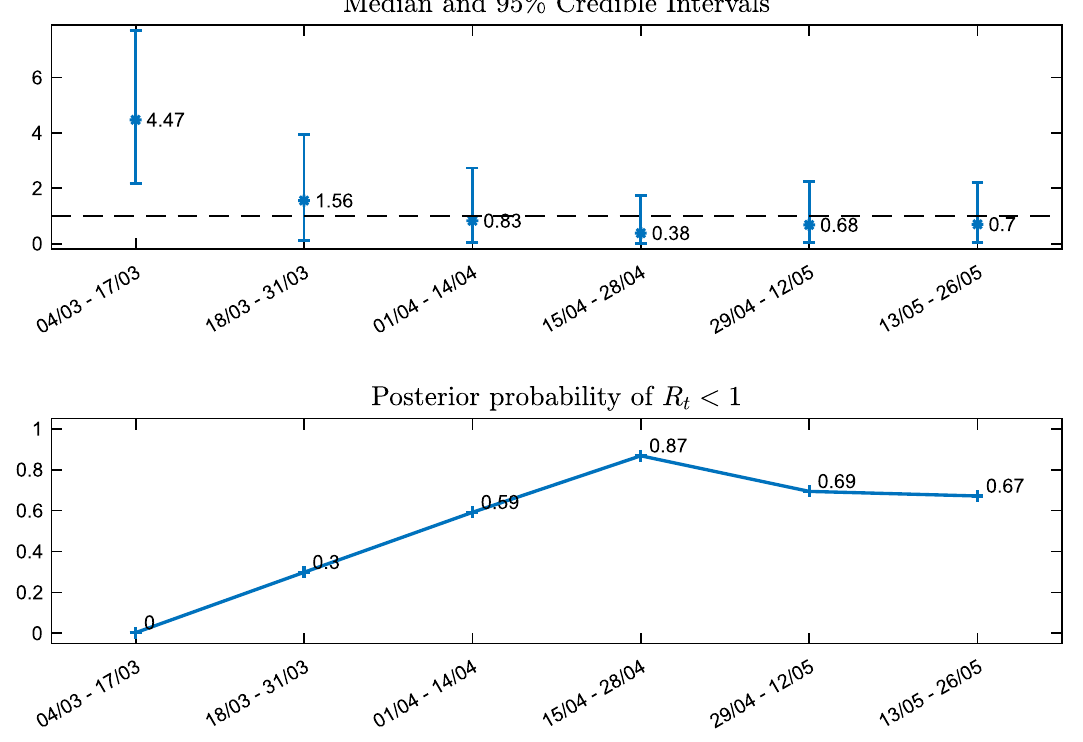
Figure 9. Top: median and 95 % credible intervals for the posterior distributions of the effective reproduction number in Model 1, for the six fortnight periods starting from 04/03/2020 until 26/05/2020. Bottom: posterior probabilities of the event R t < 1 . Analysis using the full